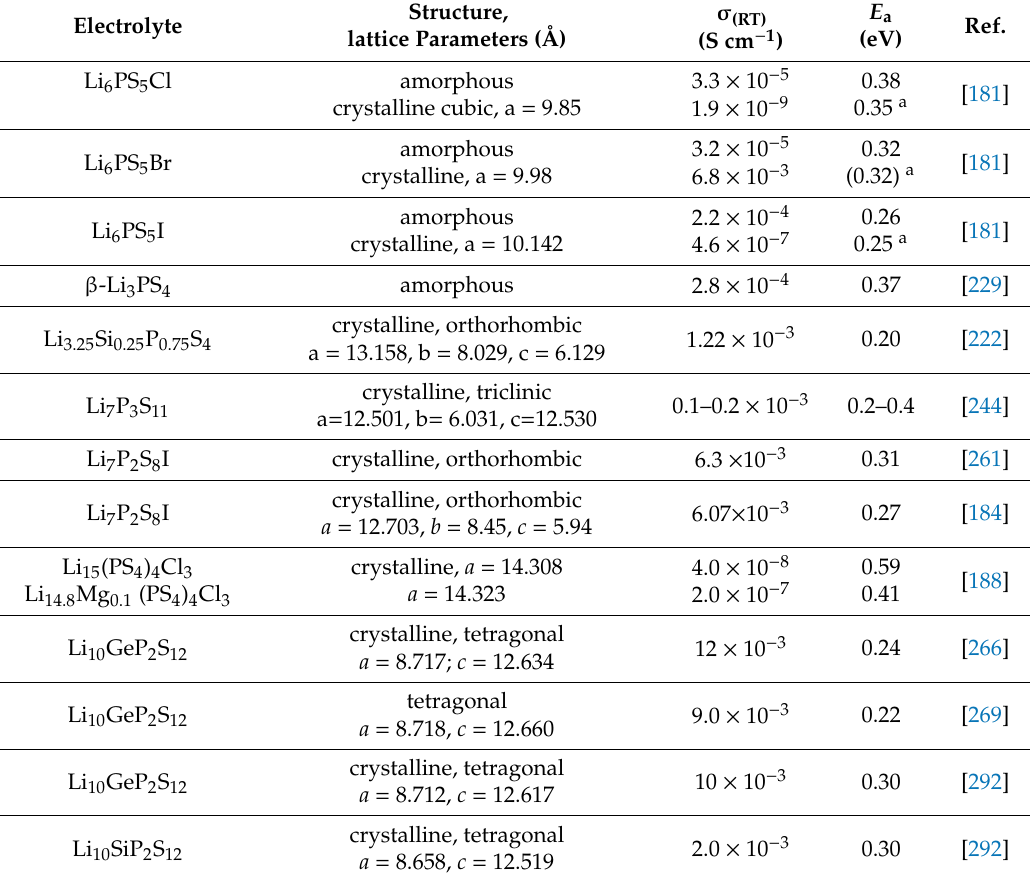
Table 1. Room temperature ionic conductivity σ (RT) and activation energy E a of sulphide solid electrolytes. Electrolyte